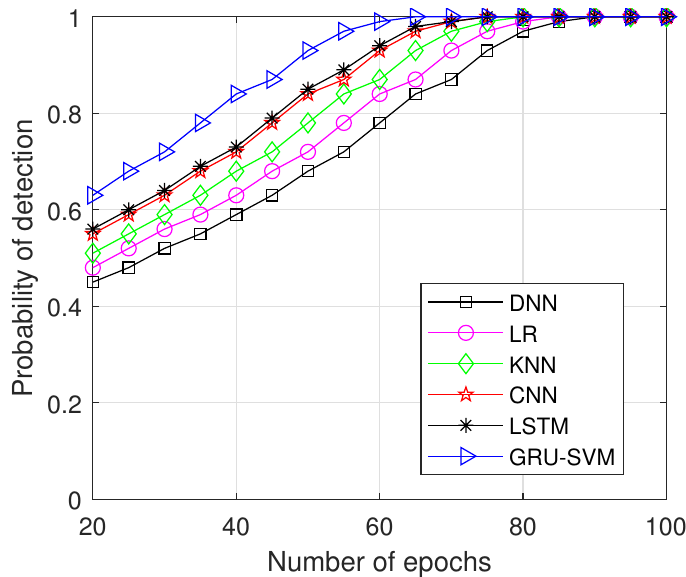
Figure 8. Testingaccuracy vs. Number of Epochs.